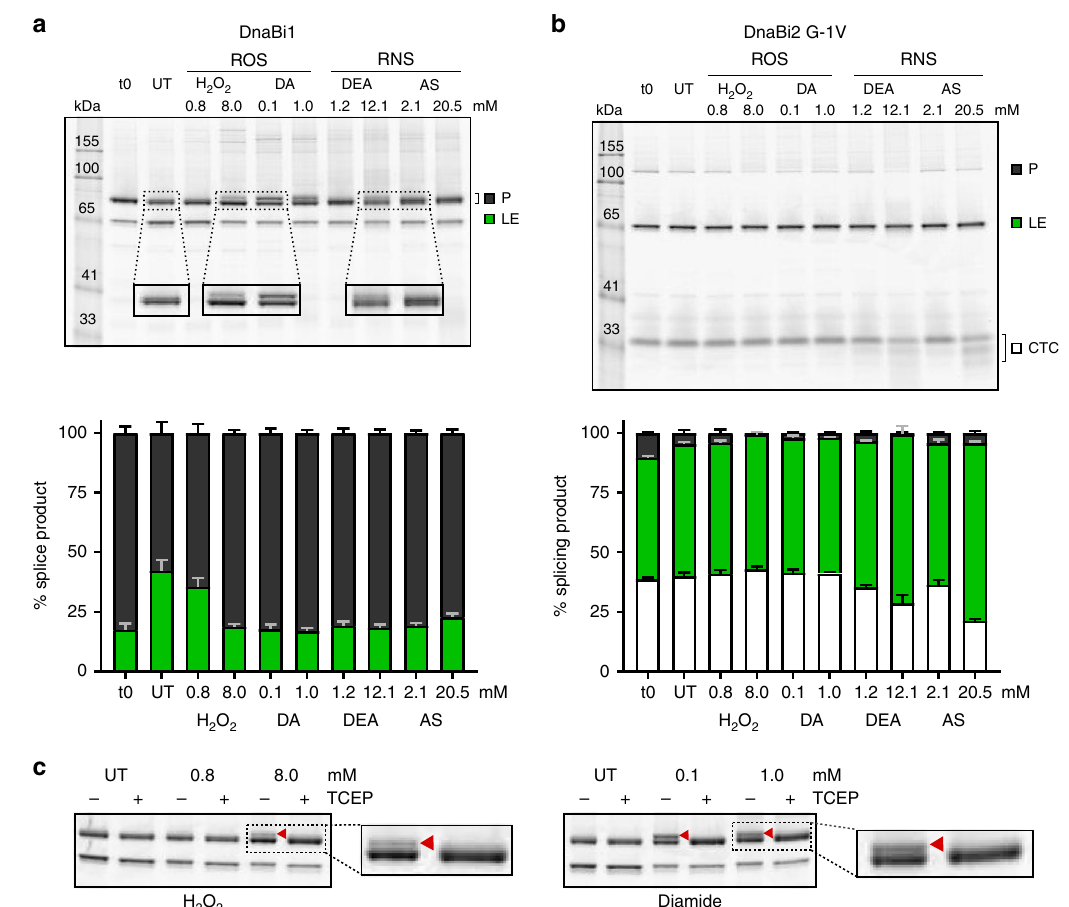
Fig. 3 M. smegmatis DnaB inteins are differentially sensitive to stressors. a MIG DnaBi1 accumulates precursor following exposure to stressors. After treatment with ROS and RNS agents there is an increase in the amount of precursor (P) compared to untreated (UT) (top). Additionally, the P band becomes diffuse (RNS) and secondary bands above P are apparent (ROS). The splicing product ratios were quantitated (stack plots below). All the treated samples, except 0.8 mM H 2 O 2 , had increased P compared to UT. DA diamide; DEA DEA NONOate; AS Angeli ’ s Salt. Data are representative of three biological replicates and values are expressed as mean ± s.d. b Splicing of MIG DnaBi2 is less responsive to stressors. A mutant version (G-1V) of MIG DnaBi2, which has slower splicing compared to WT (Fig. 2), was evaluated for changes in response to ROS and RNS treatment (top). Unlike MIG DnaBi1, there is no condition that results in precursor accumulation or visible differences in the appearance of the P bands. The splicing product ratios in response to stressors were quantitated (stack plots below). Data are representative of three biological replicates and values are expressed as mean ± s.d. c MIG DnaBi1 upper bands are reducible. Reducing agent TCEP was added to UT and ROS-treated samples. The upper bands seen in ROS-treated samples (H 2 O 2 and DA; red arrowhead) resolved into single precursor bands following treatment, suggesting that a reversible modi fi cation is occurring in response to treatment. Data are representative of three